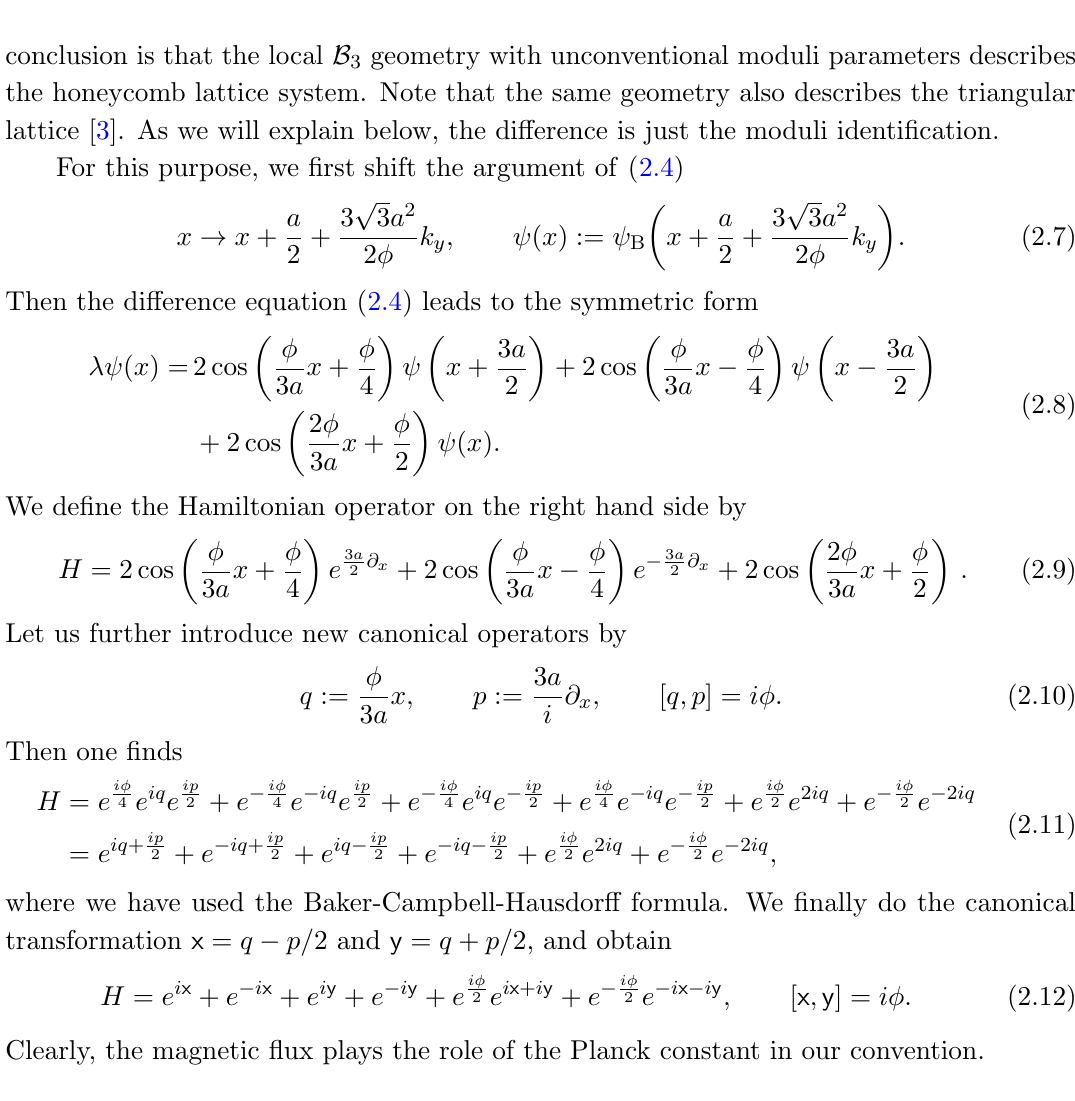
Figure 2 . The spectra of (cid:21) (left) and of E (right) as functions of the \rational" magnetic (cid:13)ux (cid:30) = 2 (cid:25)a=b with all coprime integers 1 (cid:20) a < b (cid:20)